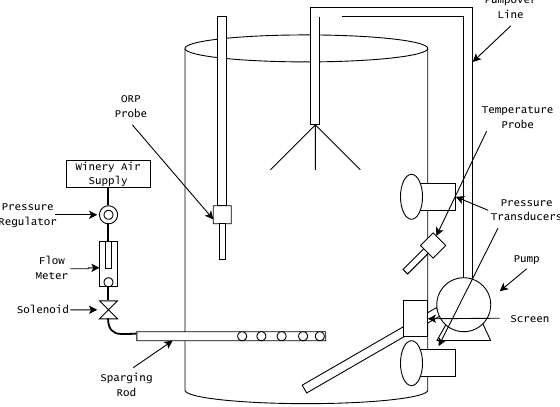
Figure 4. Experiment cross section at 10,000 L scale. Oxidation-reduction potential (ORP) probes (243050, Hamilton Company; Reno, NV, USA) were placed in the fermentors to monitor the redox potential in real time and export the values into a database. The probes were referenced to a silver/silver chloride electrode (+220 mV) and prepared before use according to the manufacturer’s recommendation.